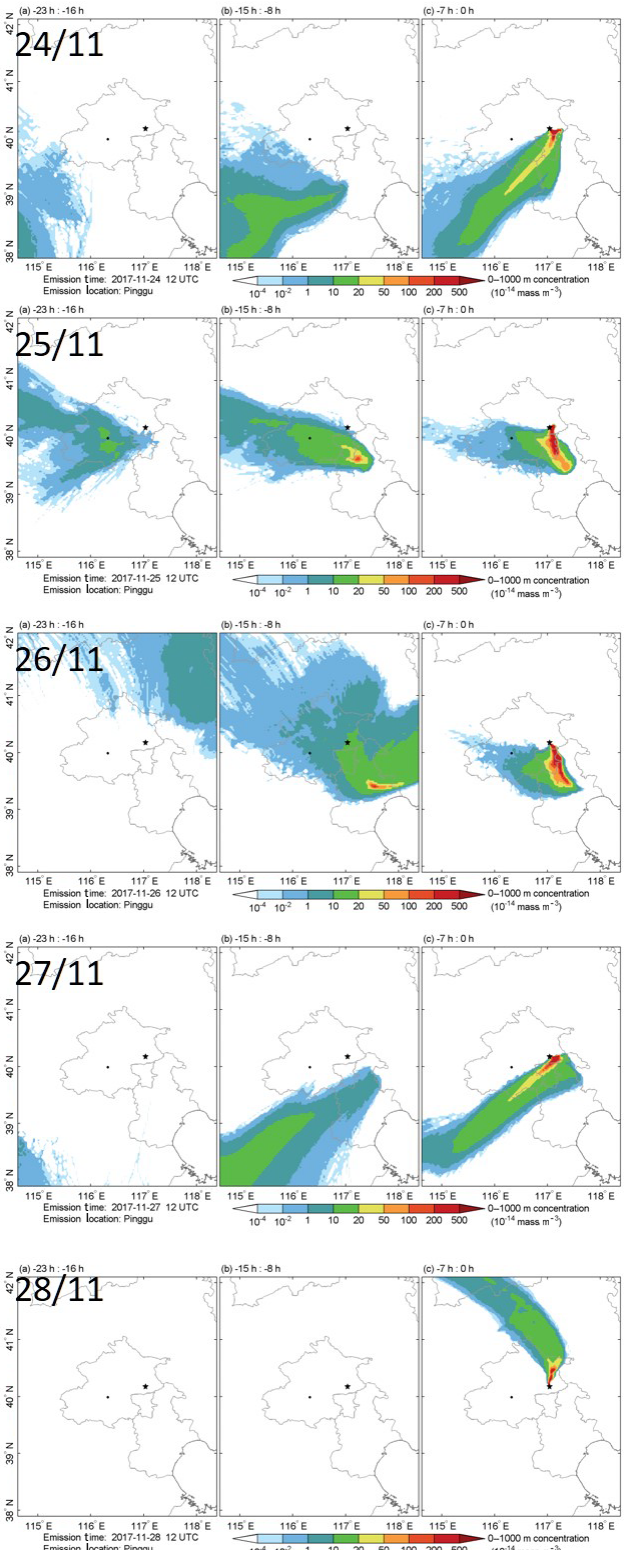
Figure 10. Typical dispersion of air mass from PG (star on the right) to PKU (dot on the left) during E1 (4 November), E2 (11 November), E3 (19 November), and E4 (26